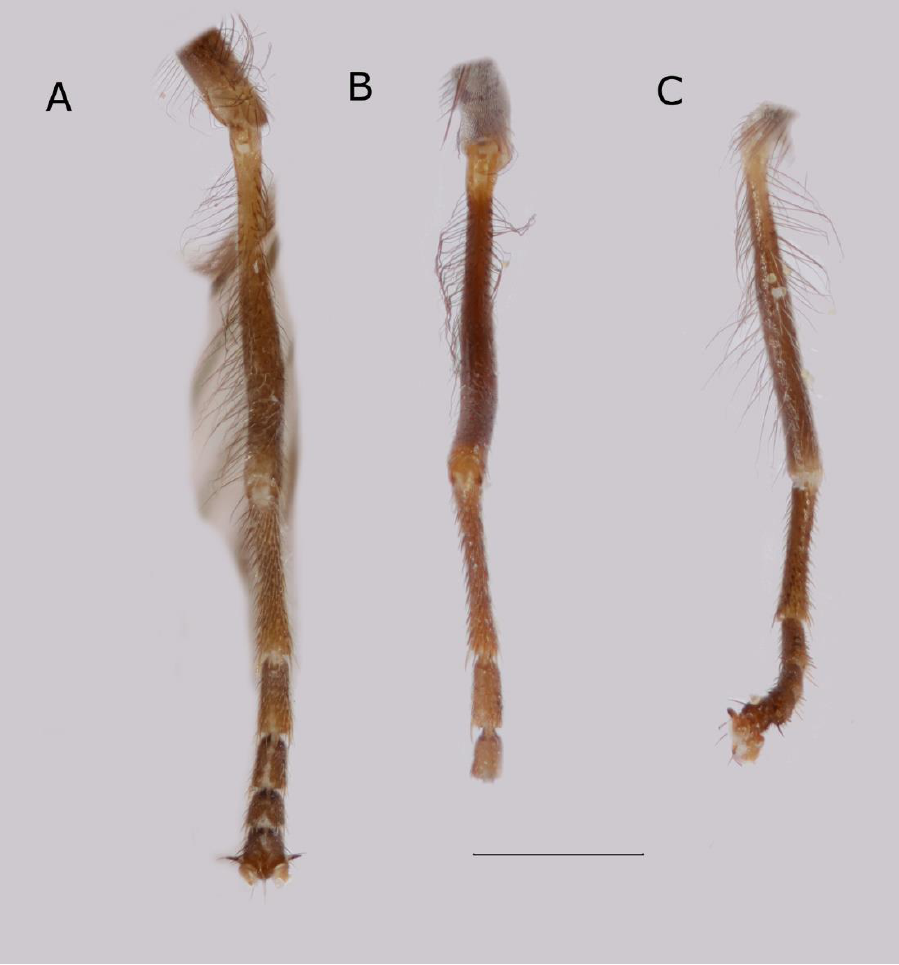
Figure 9. Adult male mesoleg, ventral view: (A) Platycheirus groenlandicus , Ammarnäs, Sweden; (B) Platycheirus subordinatus , Seitajaure, Sweden; (C) Platycheirus torei , Seitajaure, Sweden. Scale bar 0.5